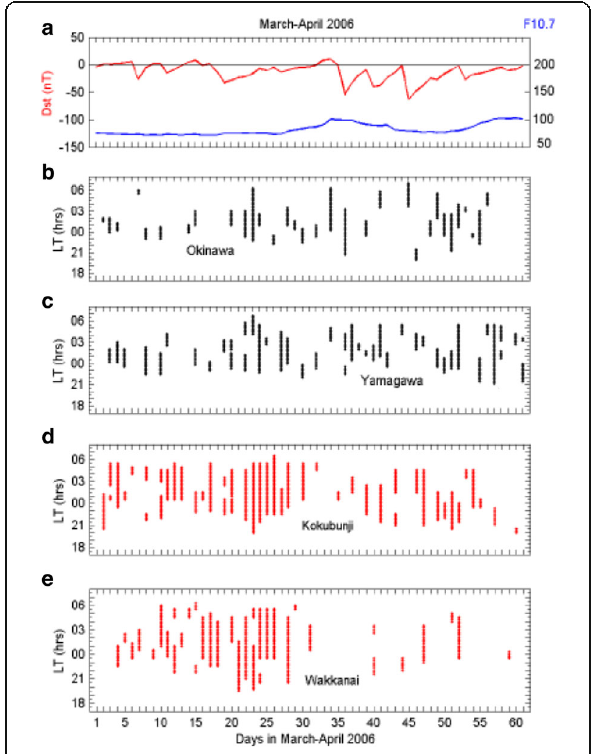
Fig. 4 Statistics of occurrence, onset time and duration of spread-F at b Okinawa, c Yamagawa, d Kokubunji and e Wakkanai in March to April 2006; black bars indicate range type spread-F, and red bars indicate frequency type spread-F. a Daily mean magnetic and solar activity indices (Dst and F10.7)